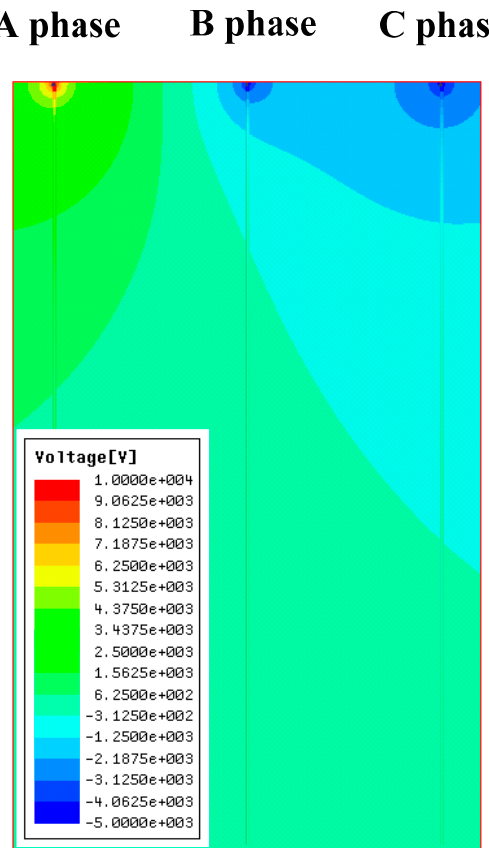
Figure 3. Voltage distribution of three-phase transmission line under the 10 kV voltage level. A line is drawn under each phase of the transmission line. The voltage value is checked at each point of the three lines, as shown in Figure 4.